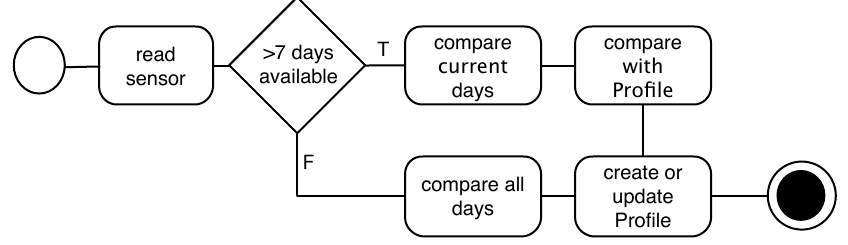
Figure 5. Abstract representation of the profile creation and administration